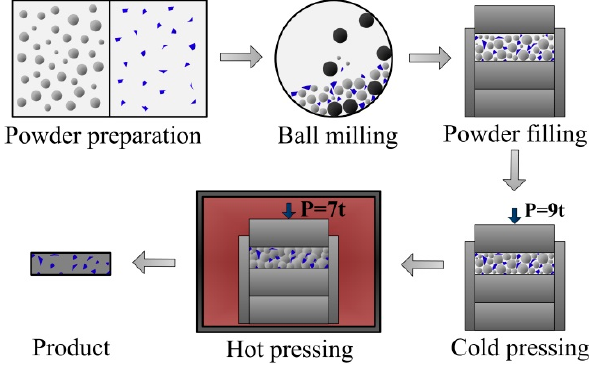
Figure 2. The manufacturing process of composites.